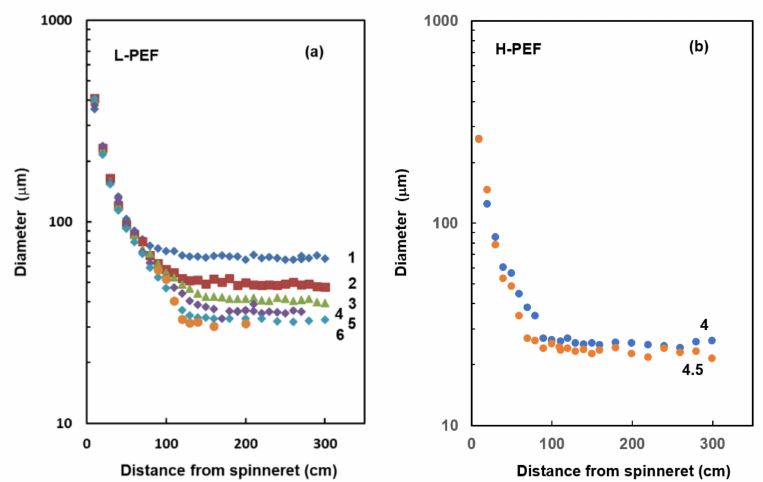
Figure 1. Diameter of ( a ) low molecular weight poly(ethylene 2,5-furandicarboxylate) (L-PEF) and ( b ) high molecular weight PEF (H-PEF) spin-line versus the distance from the spinneret. Take-up velocity (km/min) is indicated in the